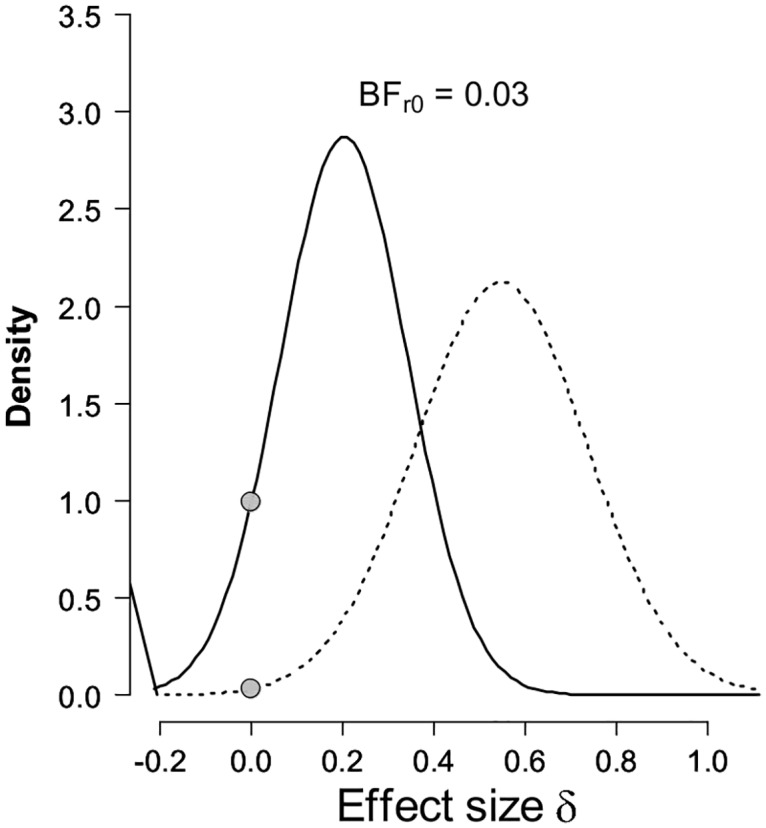
Bayesian results of the replication test for the right-frontal positivity identified previously during preparation for episodic memory retrieval on switch trials.The dotted line represents the posterior from the original study [15], which was used as the prior for the effect size in the replication test. The solid line represents the posterior distribution after the data from the replication attempt (Experiment 1) are taken into account. The grey dots indicate the ordinates of this prior and posterior for the null hypothesis that the effect size is zero. The ratio of these two ordinates gives the result of the replication test [22].